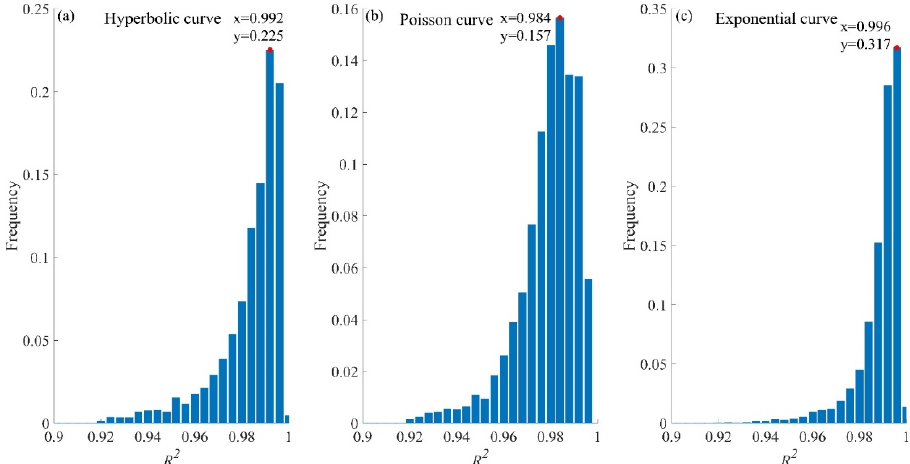
Figure 8. R 2 of ( a ) Hyperbolic curve fitting, ( b ) Poisson curve fitting and ( c ) Exponential curve fitting.